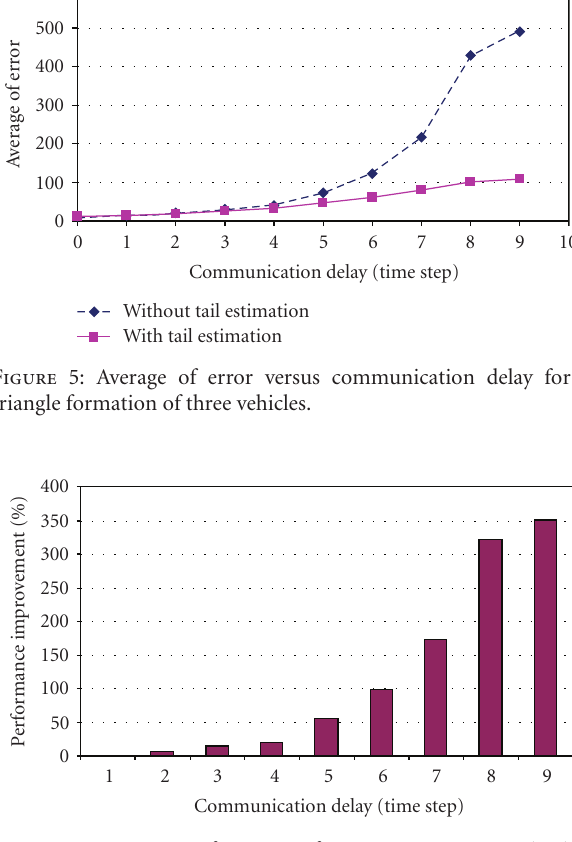
Figure 6: Percentage of average of error versus communication delay for a triangle formation of three